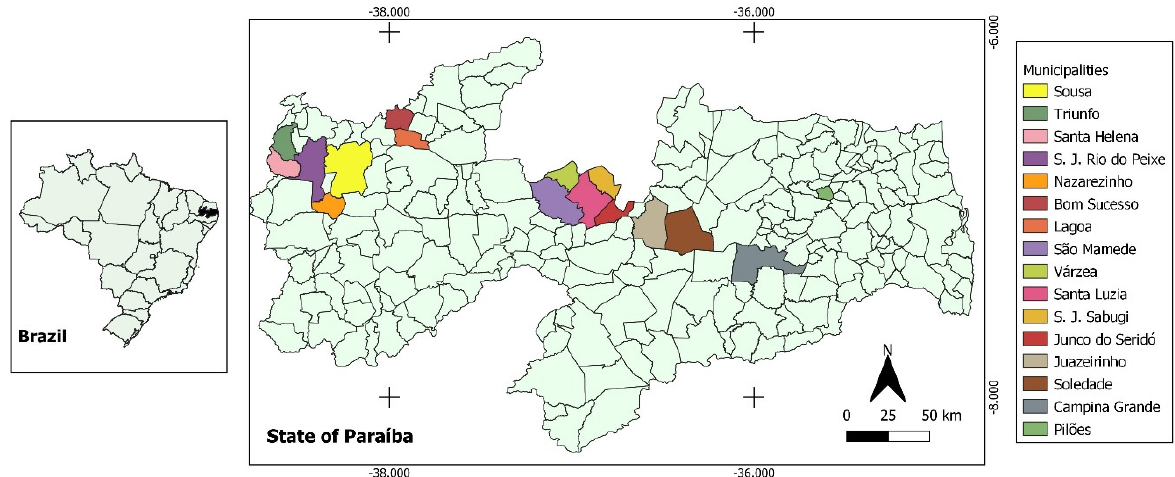
Figure 1. Geographic location of municipalities in the state of Paraíba, Northeast Brazil, where samples of urban traction equids were collected to assess the prevalence and risk factors associated with positivity for anti- T. gondii and anti- N. caninum antibodies.